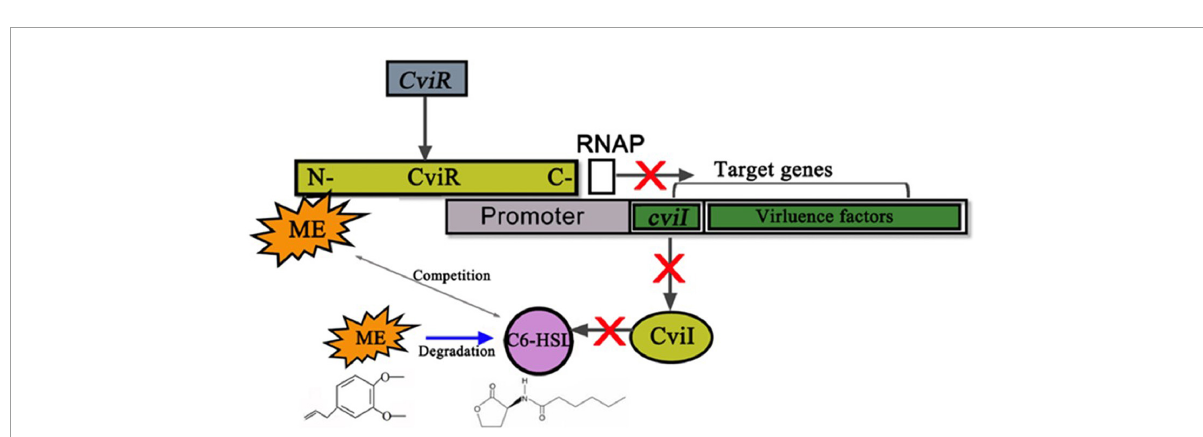
FIGURE8 Putative mechanism for the inhibition of Chomobacterium violaceum Quorum sensing (QS) by methyleugenol (ME). ME may complete with C6-HSL for binding CviR to reduce the enzyme activity of cviR (gray arrow between ME and C6-HSL). Subsequent cviI and virulence factors, which positively regulated by cviR , were repressed by ME. The RNAP represents the RNA polymerase. Meanwhile, the gray arrows stand for the positive regulatory. Blue arrow between ME and C6-HSL meant that ME was able to degrade the C6-HSL. Red X marks represent the block